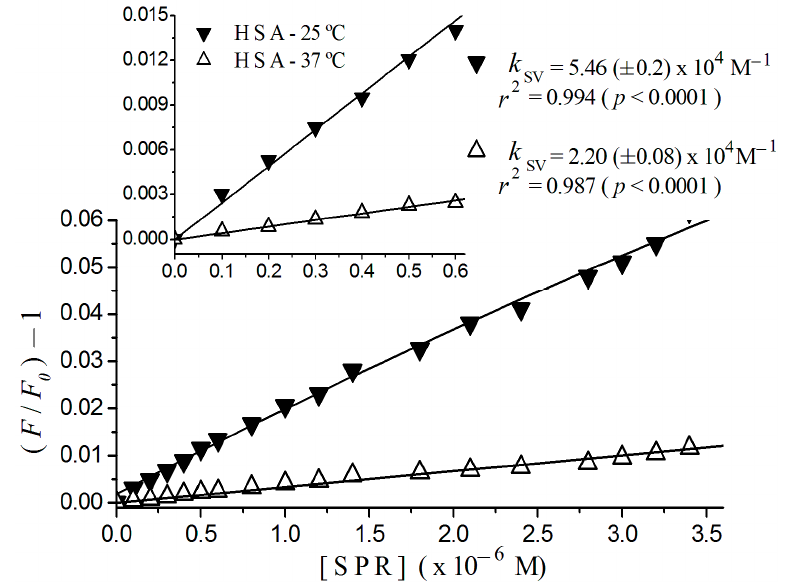
Figure 2. Stern-Volmer plots of HSA titrated with sulpiride at 25 and 37 °C. Excitation λ = 290 nm; (albumin) = 2 × 10 − 6 M; 10 − 3 M phosphate buffer, pH 7.4, [SPR] = sulpiride concentration. Detail shows plot region for low sulpiride concentration region with regression coefficient and Stern-Volmer constant estimated for this region.